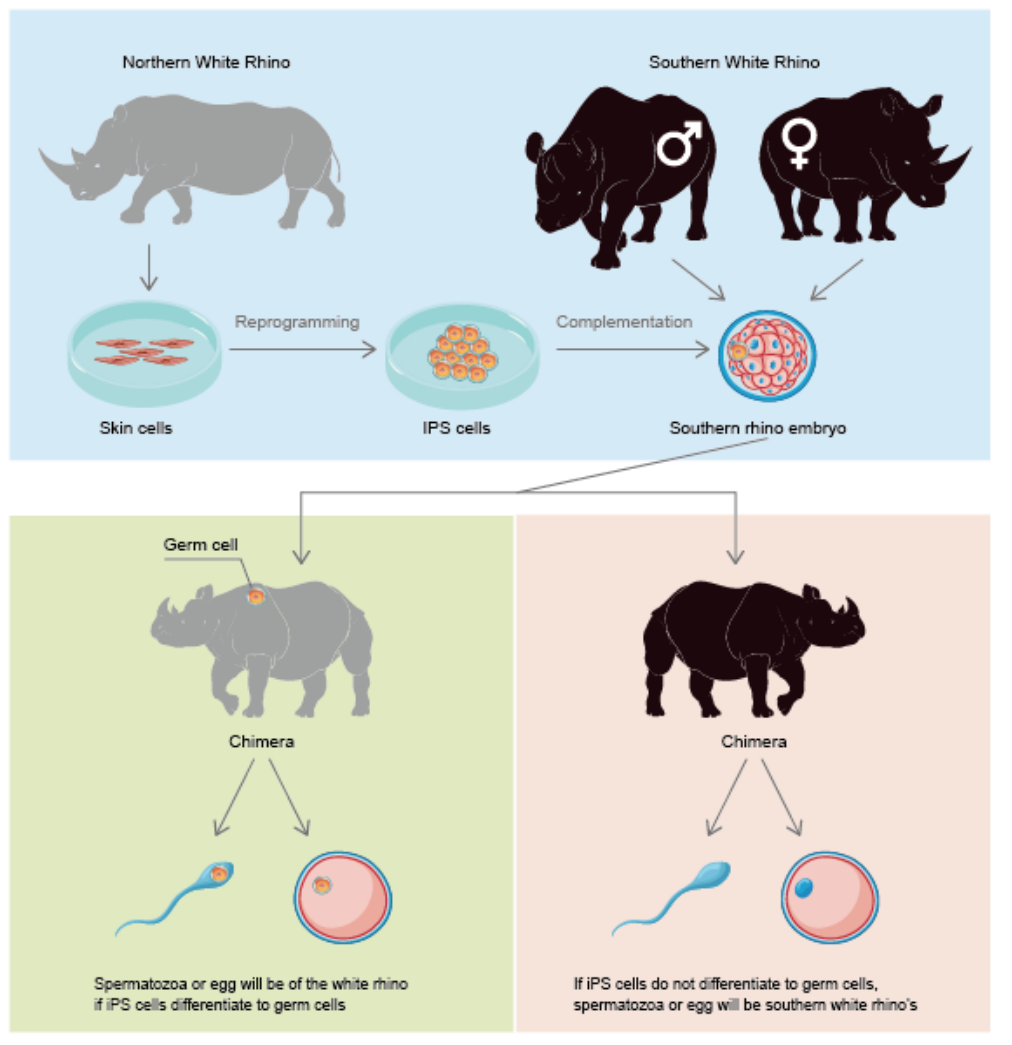
Figure 5. Pictorial presentation of iPSC technology as an asset for White Rhino revival.